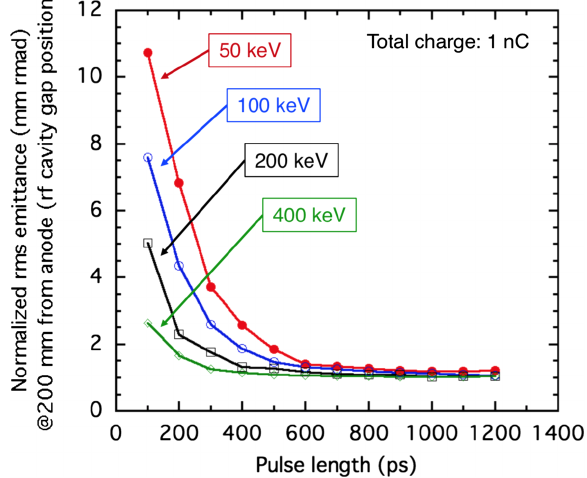
FIG. 2. Dependence of emittance growth on the beam pulse length for various gun high voltages. The extraction charge was fixed at 1 nC.